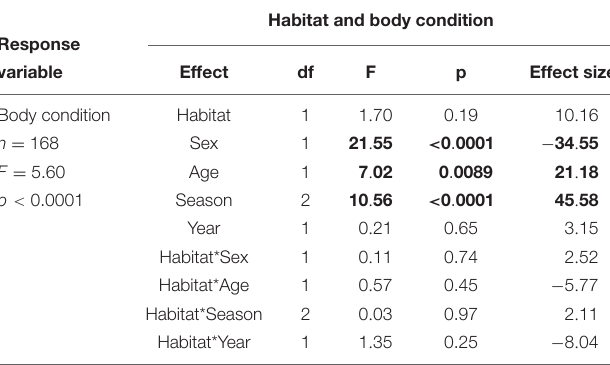
TABLE 2 | Results of model testing whether the ability of blood plasma to prevent the growth of E. coli and S. paratyphi relates to habitat (urban or natural) in which a bird is captured, sex, age, season, and year of capture.